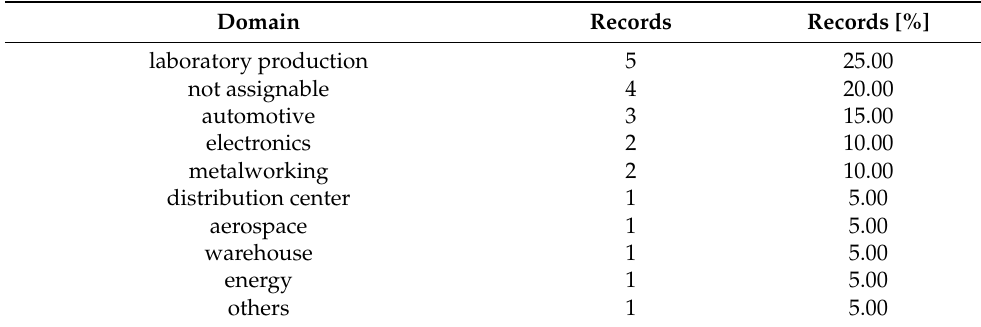
Table 12. Application